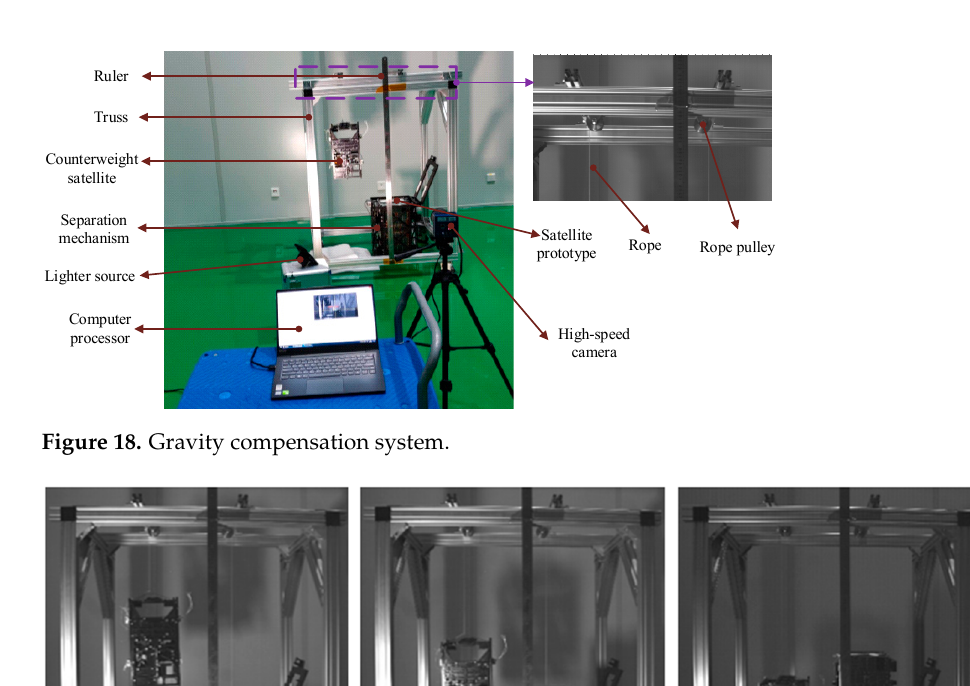
Figure 19. Separation process. ( a ) Initial state; ( b ) Intermediate state; ( c ) Popup state.